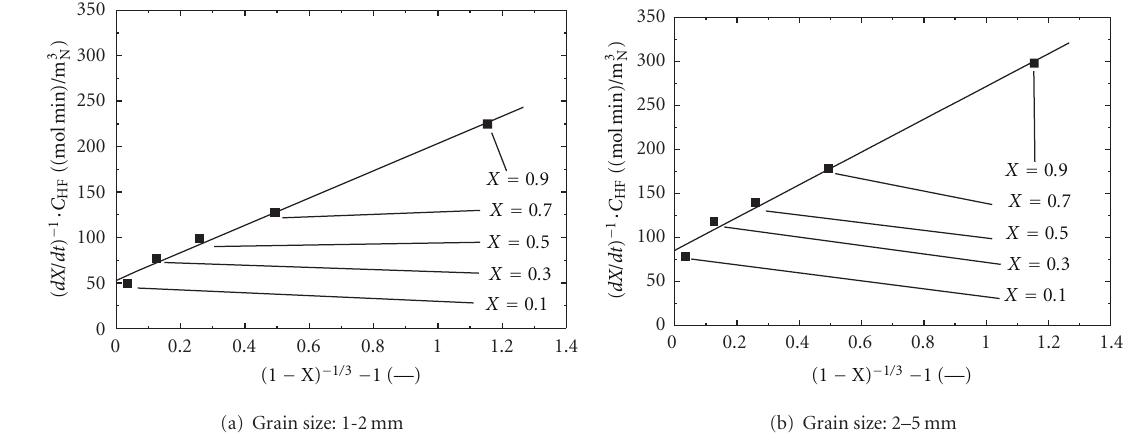
Figure 9: Plots of ( dX / dt ) − 1 · C HF versus (1 − X ) − 1 / 3 − 1. Table 3: Rate constants of the gas-solid reaction of HF and CaCO 3 .